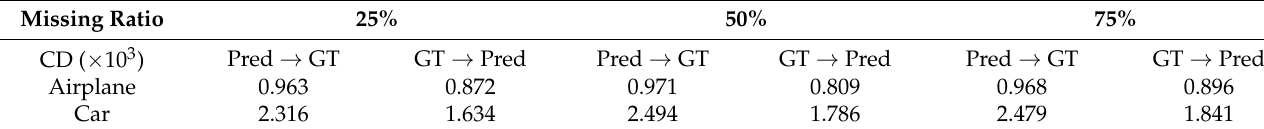
Table 5. Robustness results of different extent of incomplete input point cloud using our method.